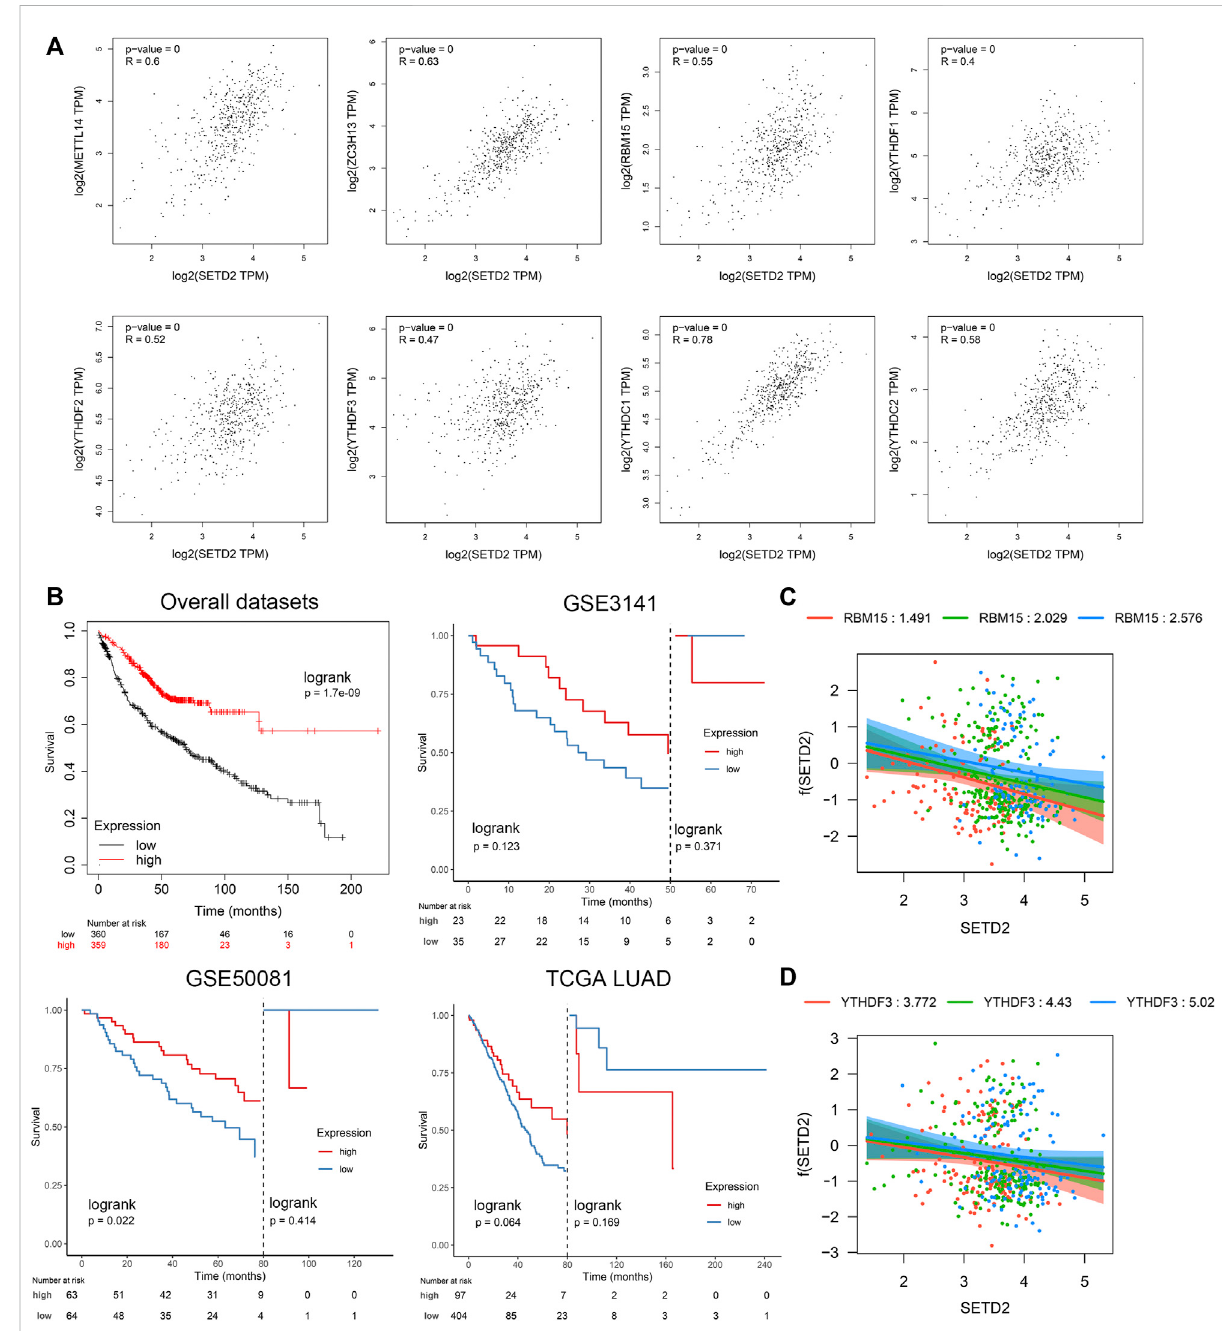
FIGURE 7 SETD2waslinkedtofavorableprognosiswhoseeffectwasnegativelyaffectedbytheinteractionofm6A-relatedgenesRBM15andYTHDF3. (A) Correlations between SETD2 and m6A-related genes. (B) Kaplan-Meier survival curves of SETD2 in the Kmplot database. (C) Visualization of interactioneffectofRBM15onCoxregressioncoef fi cientofSETD2. (D) VisualizationofinteractioneffectofYTHDF3onCoxregressioncoef fi cientof